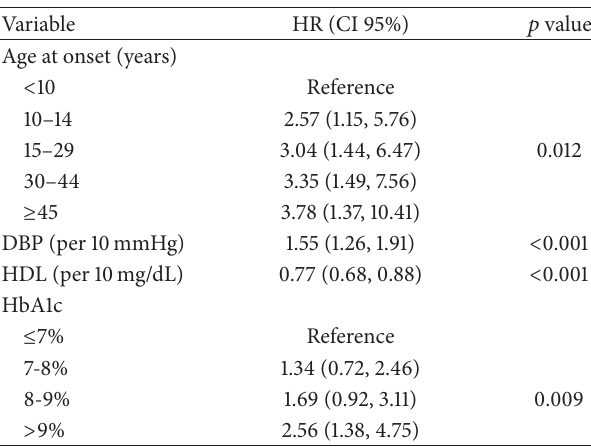
Table 3: Univariate analysis to analyze the association between age, gender, and other risk factors at T1D onset with the development of DR during the subsequent follow-up period.